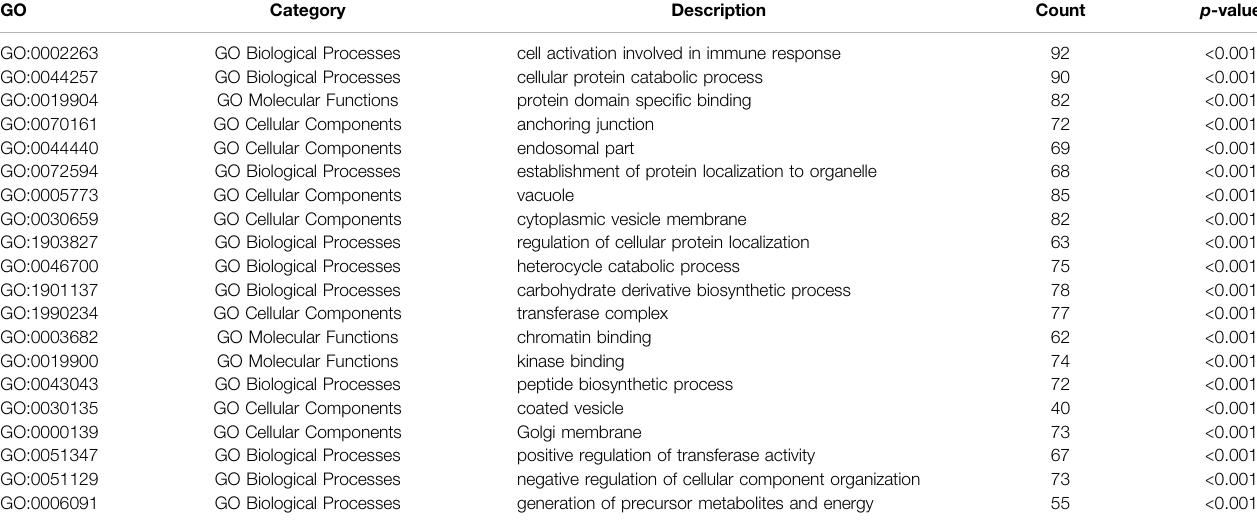
TABLE 3 | GO analysis of WCGNA grey